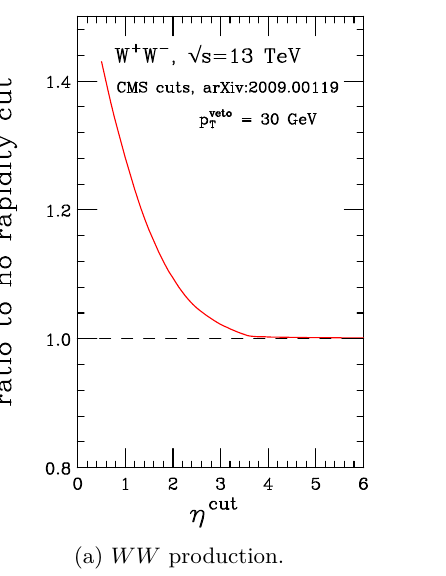
Figure 6 . Effect of the jet rapidity cut at NNLO with p veto